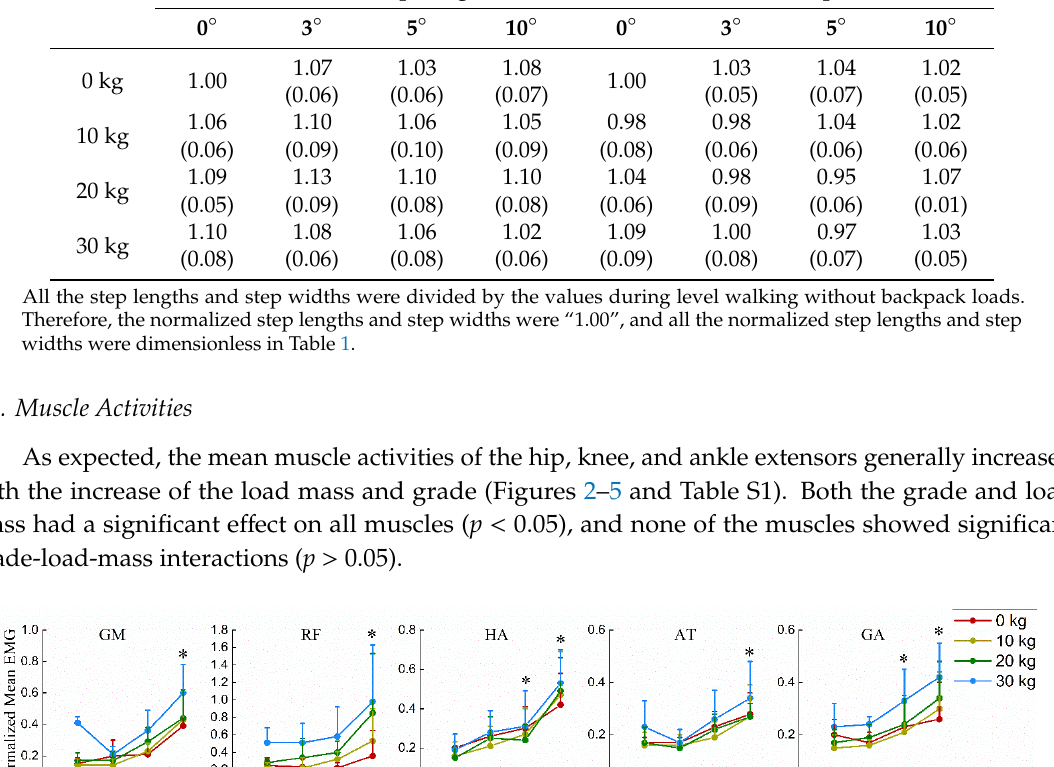
Table 1. Normalized step lengths and step widths during di ff erent grades of walking with di ff erent load masses. Normalized Step Length